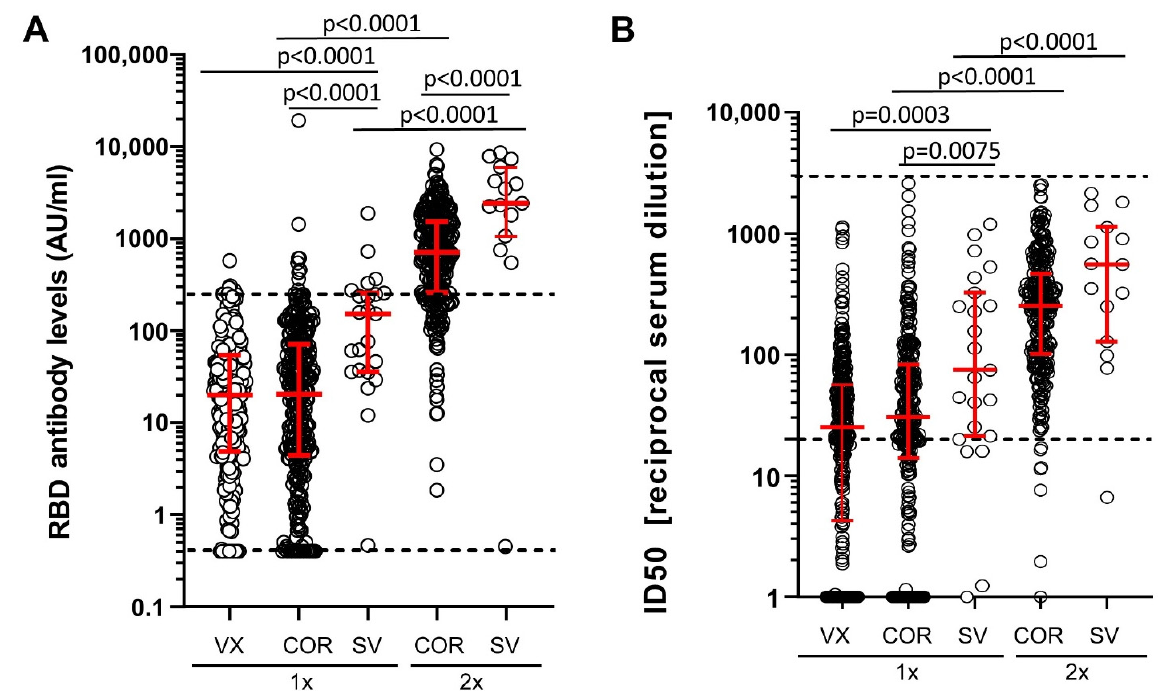
Figure 2. RBD binding and neutralizing antibodies in uninfected participants after vaccination. ( A ) Binding antibody levels to RBD (arbitrary units, AU) and ( B ) neutralizing antibodies (ID50) in N-antibody seronegative participants vaccinated once (1×) or twice (2×) with Vaxzevria (VX), Comirnaty (COR), or Spikevax (SV). The Kruskal–Wallis test including all five groups indicated significant differences for the RBD and neutralizing antibody levels (( A ) p < 0.0001, ( B ) p < 0.0001, judged at 5% significance level). Pairwise comparisons were performed to (i) compare antibody response to one vaccination between vaccine types (COR vs. VX, SV vs. VX, SV vs. COR), (ii) compare two versus one vaccination (COR-2x vs. COR-1x, SV-2x vs. SV-1x) and (iii) compare two vaccinations of different vaccine types (SV-2x vs. COR-2x). p -values of these pairwise group comparisons with the Mann–Whitney test are shown (judged for significance at a Bonferroni-corrected level of 0.05/6 = 0.008 to account for 6 tests). Dashed lines mark the upper and lower limits of the linear range of the